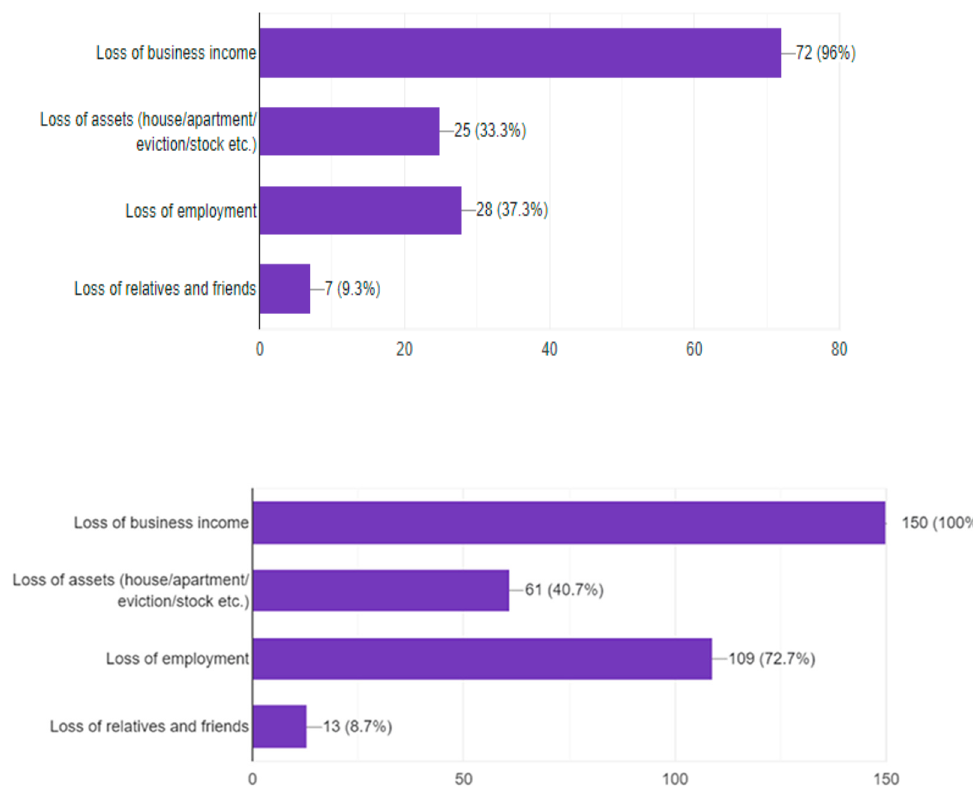
Figure 2. The socio-economic impact of COVID-19 on in KwaDukuza and eThekwini. Source: Author’s own.